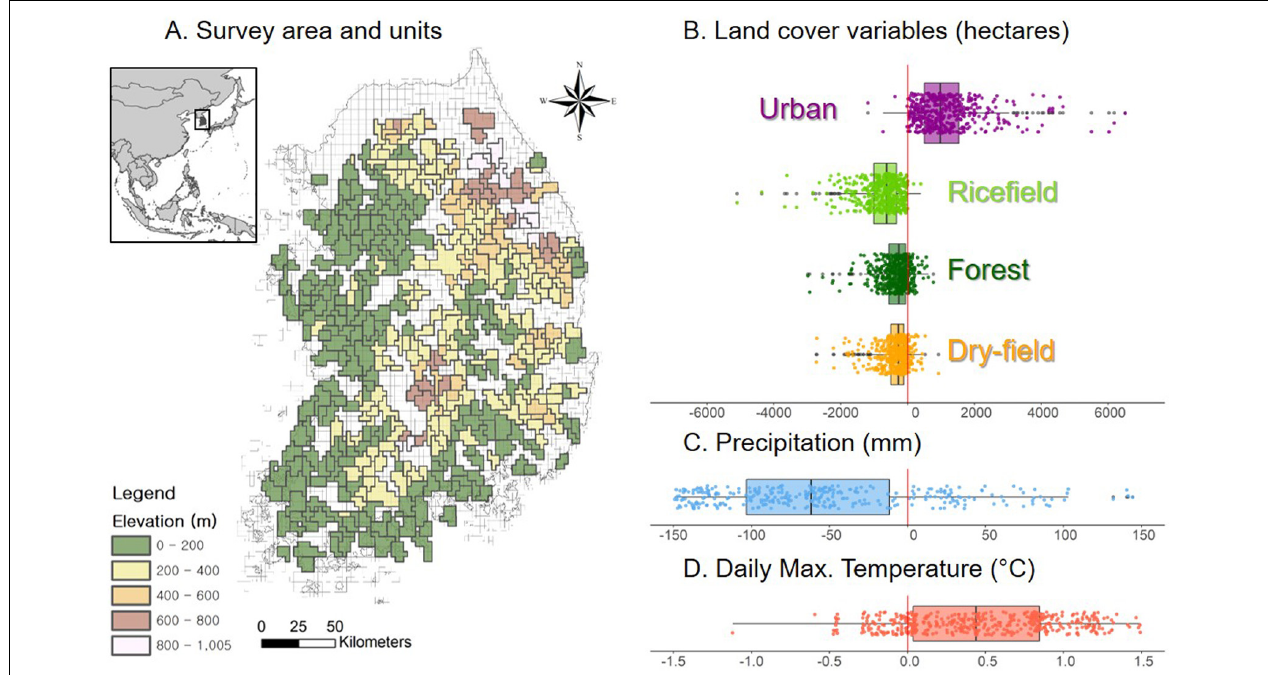
FIGURE 1 | (A) Distribution of sampling units across South Korea. The sampling units are aggregated grids that match the spatial extent of the 1997–2005 survey units. (B) Differences in land-cover area per sampling unit between two periods. (C) Differences in average May-June precipitation and (D) daily maximum temperatures per each sampling